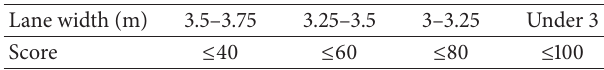
Table 5: Radius standard for plane curve for design speed.